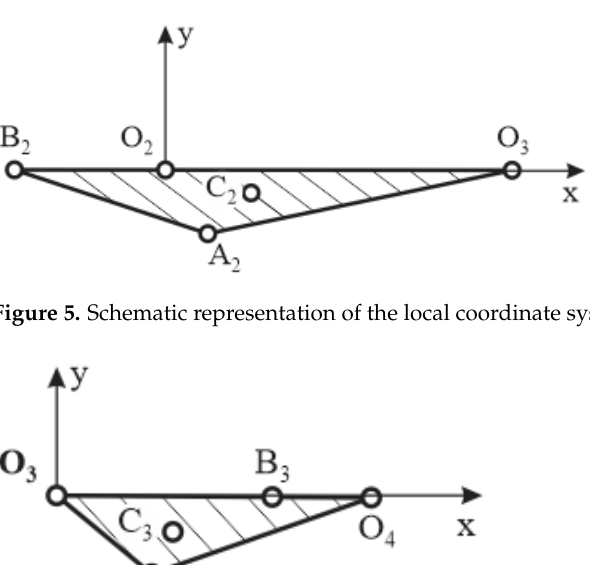
Figure 4. Schematic representation of the local coordinate system of arm no. 1.